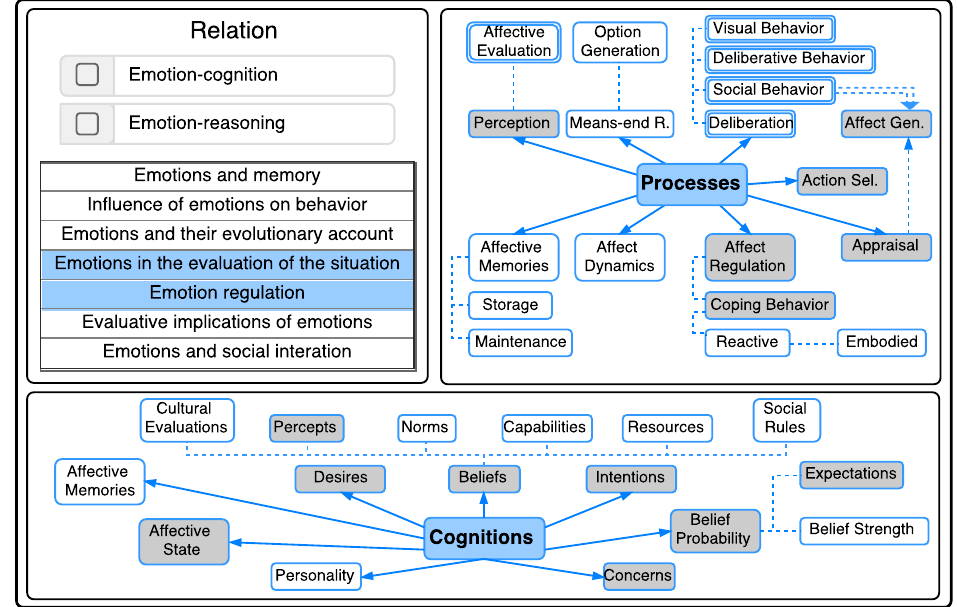
Figure 8. Processes and cognitions of the model of coping